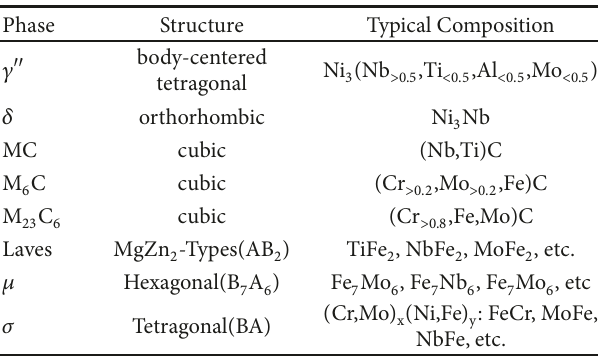
Table1:Themainphasesoccurringinlong-termagingnickel-based superalloy.